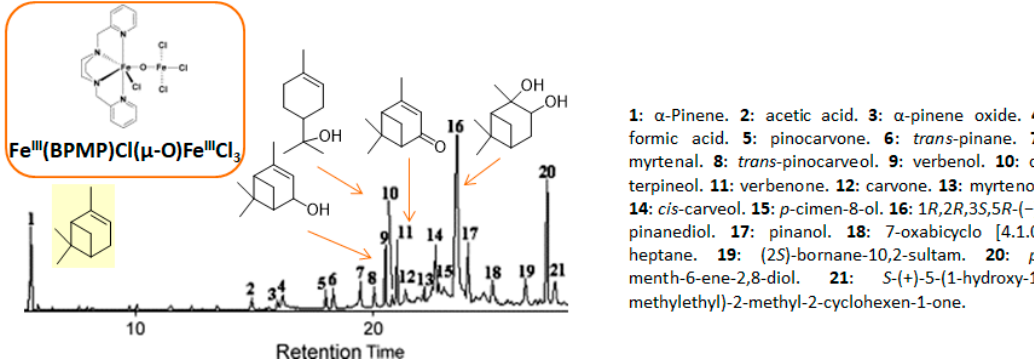
Figure 2. Chromatogram of the challenging α -pinene oxidation with [Fe III (BPMP)Cl( μ -O)Fe III Cl 3 ] (adapted from reference [11]).